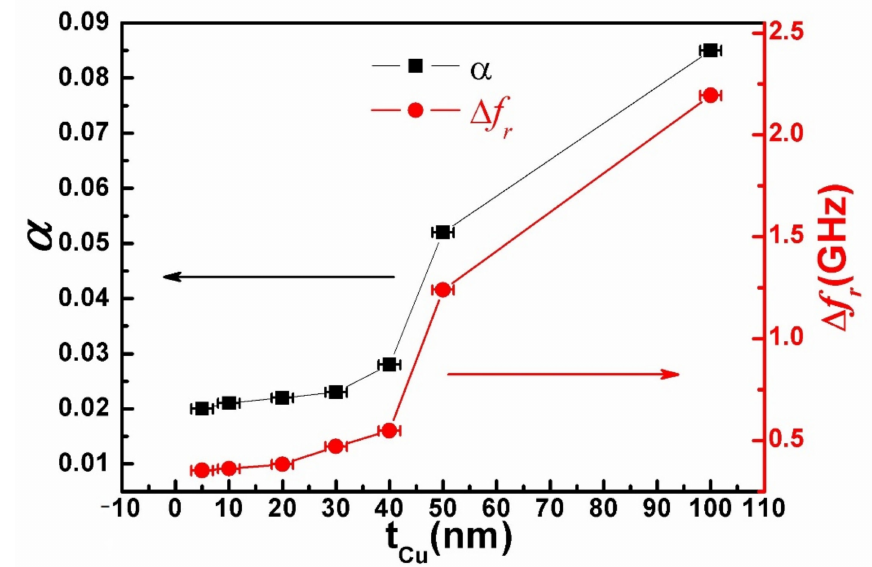
Figure 6. The dependence of α and ∆ f r on Cu underlayer thickness t Cu